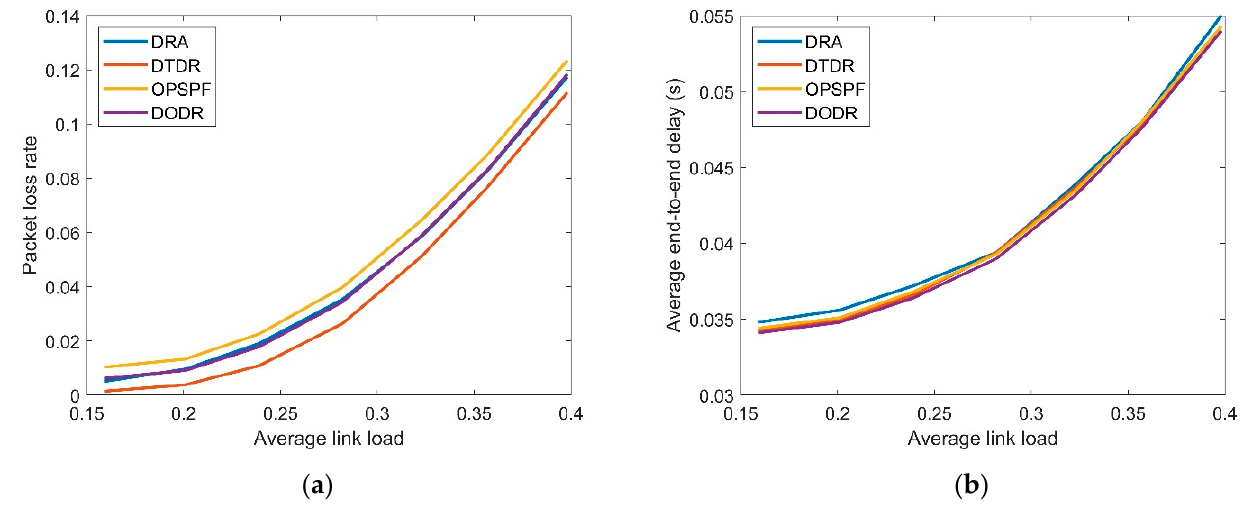
Figure 8. ( a ) Packet loss rate under different average link loads; ( b ) average end-to-end delay under different average link loads.